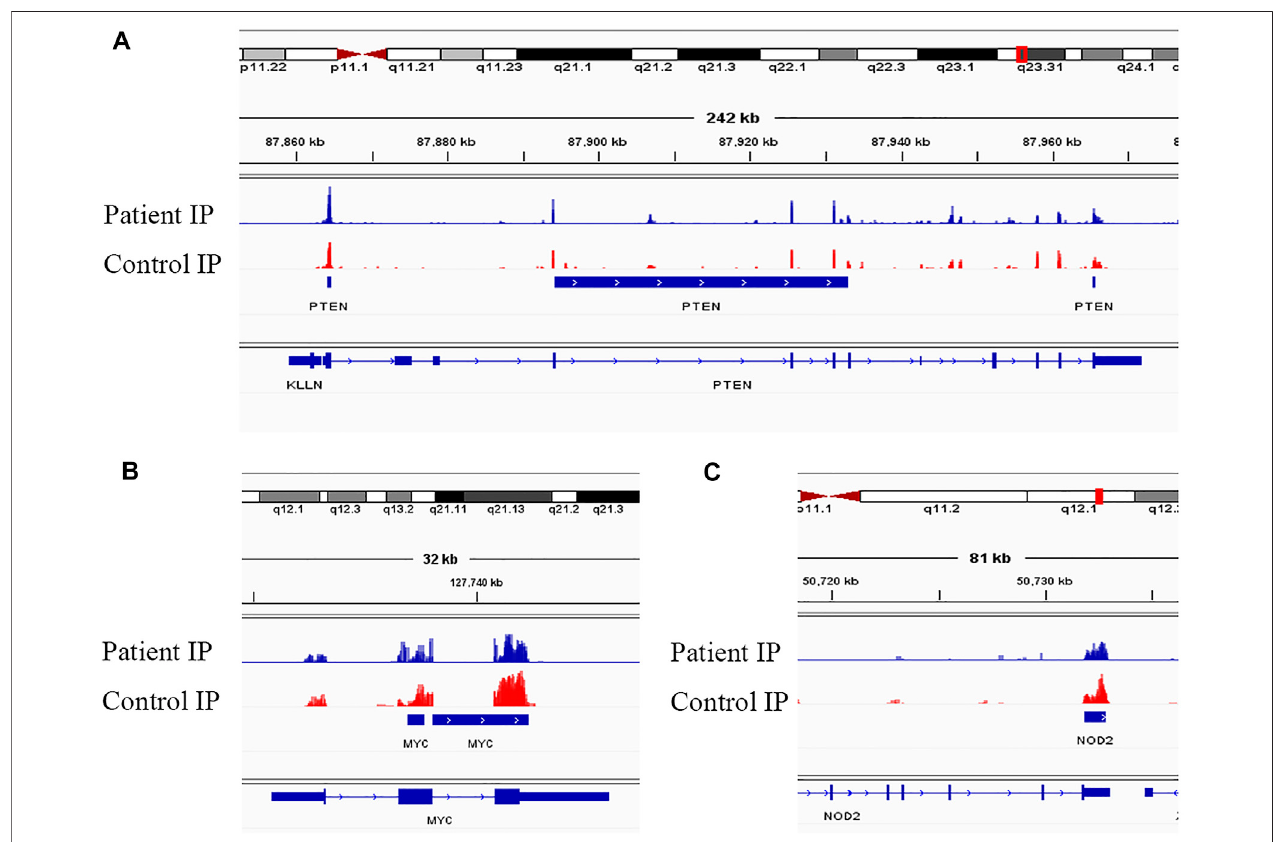
FIGURE 5 | Visualization of representative genes. (A) Visualization of the m 6 A-modi fi ed gene PTEN in NMOSD patients and HCs. (B) Visualization of the m 6 A-modi fi ed gene MYC in NMOSD patients and HCs. (C) Visualization of the m 6 A-modi fi ed gene NOD2 in NMOSD patients and HCs.